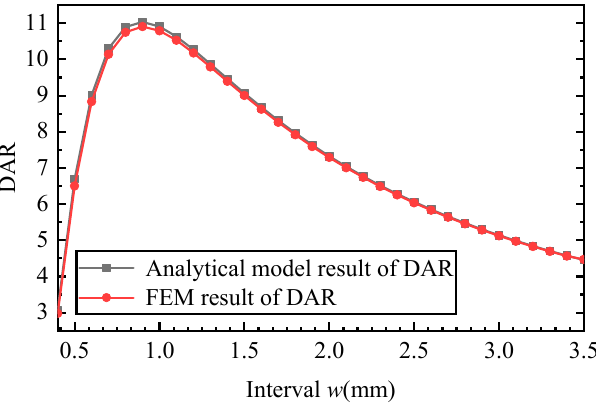
Figure 10. The changes in DAR with the interval of adjacent flexure hinges varied.